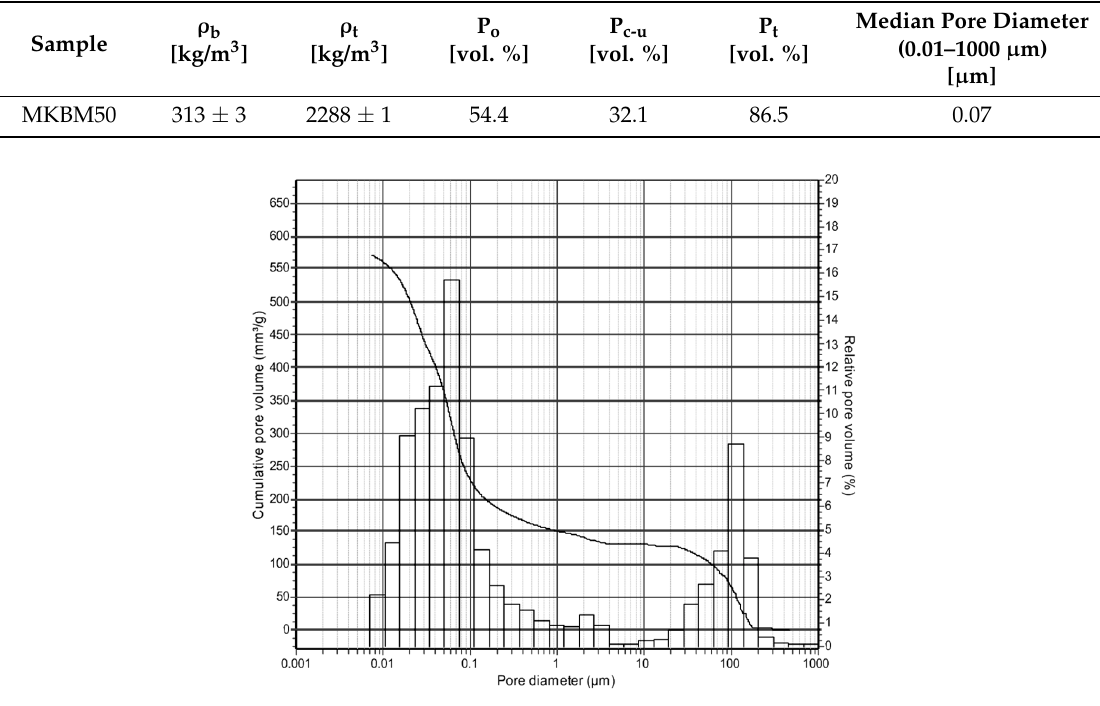
Figure 5. Open pore size distribution for MKBM50.